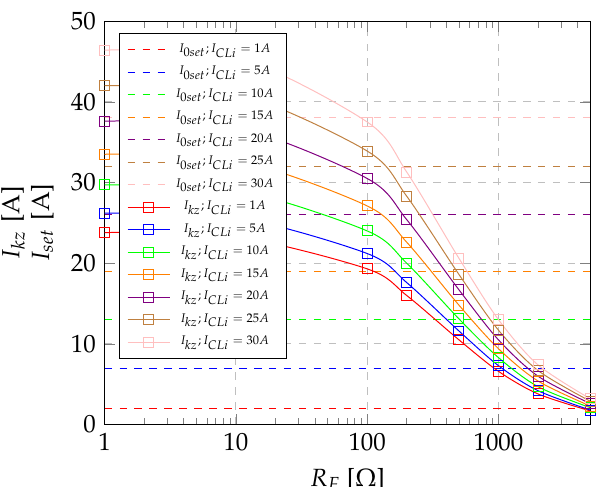
Figure 3. The values of the I kz and I 0 set currents in the compensated network for different values of I CLi